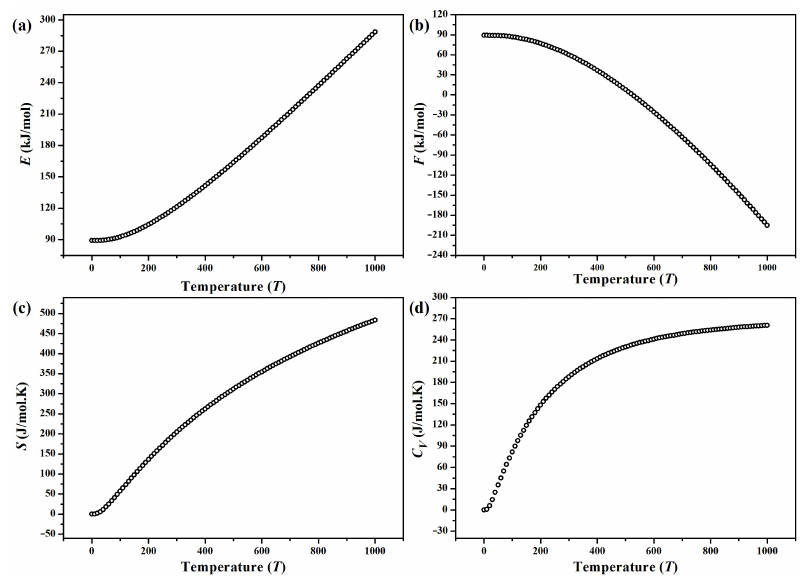
Figure 7. Temperature-dependent ( a ) total (internal) energy E , ( b ) Helmholtz free energy F , ( c ) entropy S and ( d ) heat capacity C V of α -Cu 2 P 2 O 7 calculated per mole (of formula units) at a molecular volume of 130.268 Å 3